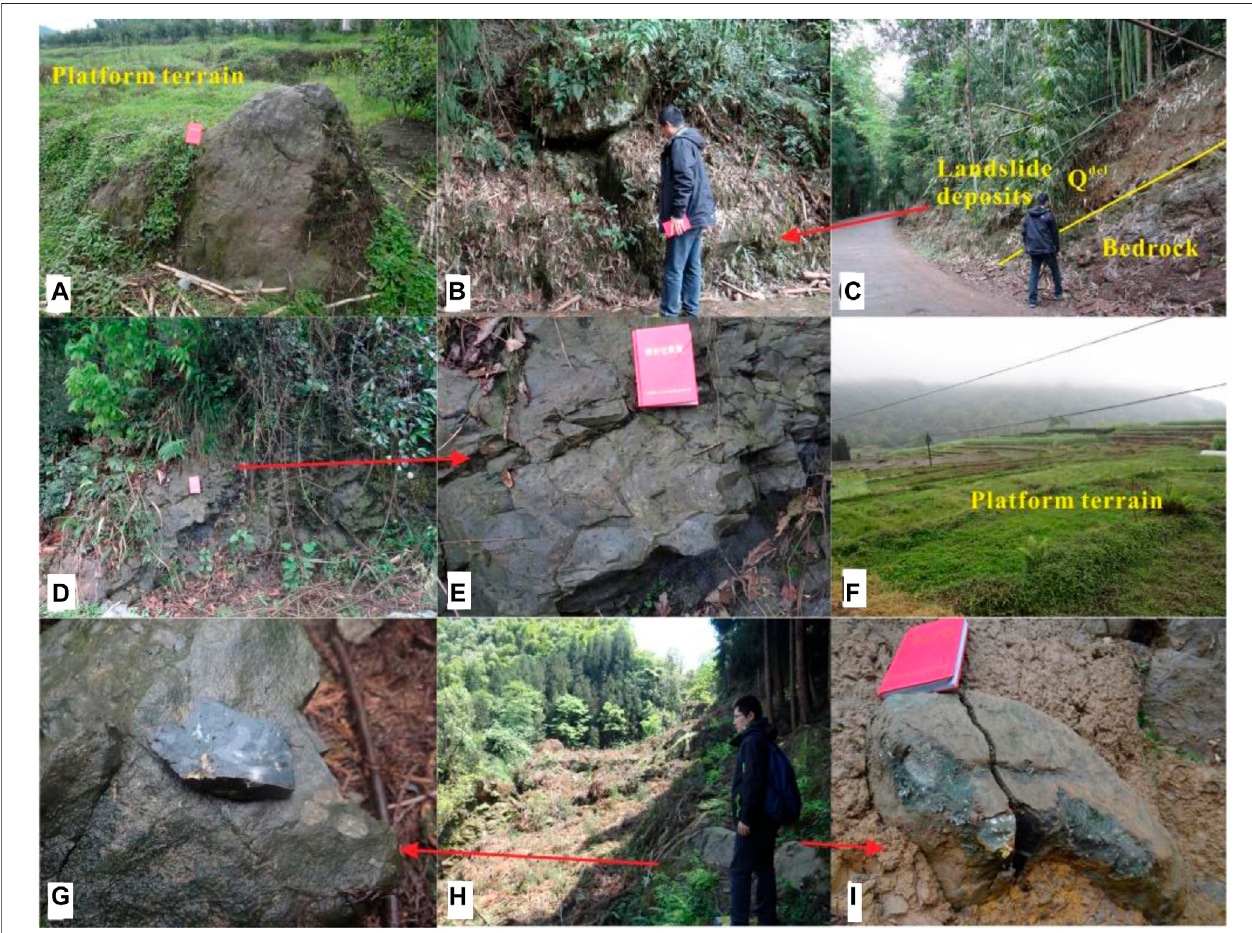
FIGURE 8 | Landslide deposits distributed around Qianchi Village. (A) Large basaltic boulders distributed at observation point D024. (C) The bedrock cover interface exposed at observation point D022. (B) Landslide deposits at the east side of the bedrock cover interface. (D,E) Large basaltic boulders distributed at observation point D025. (F) Landslide accumulation platform in Qianchi Village. (G,H,I) Landslide deposits at observation point D068.